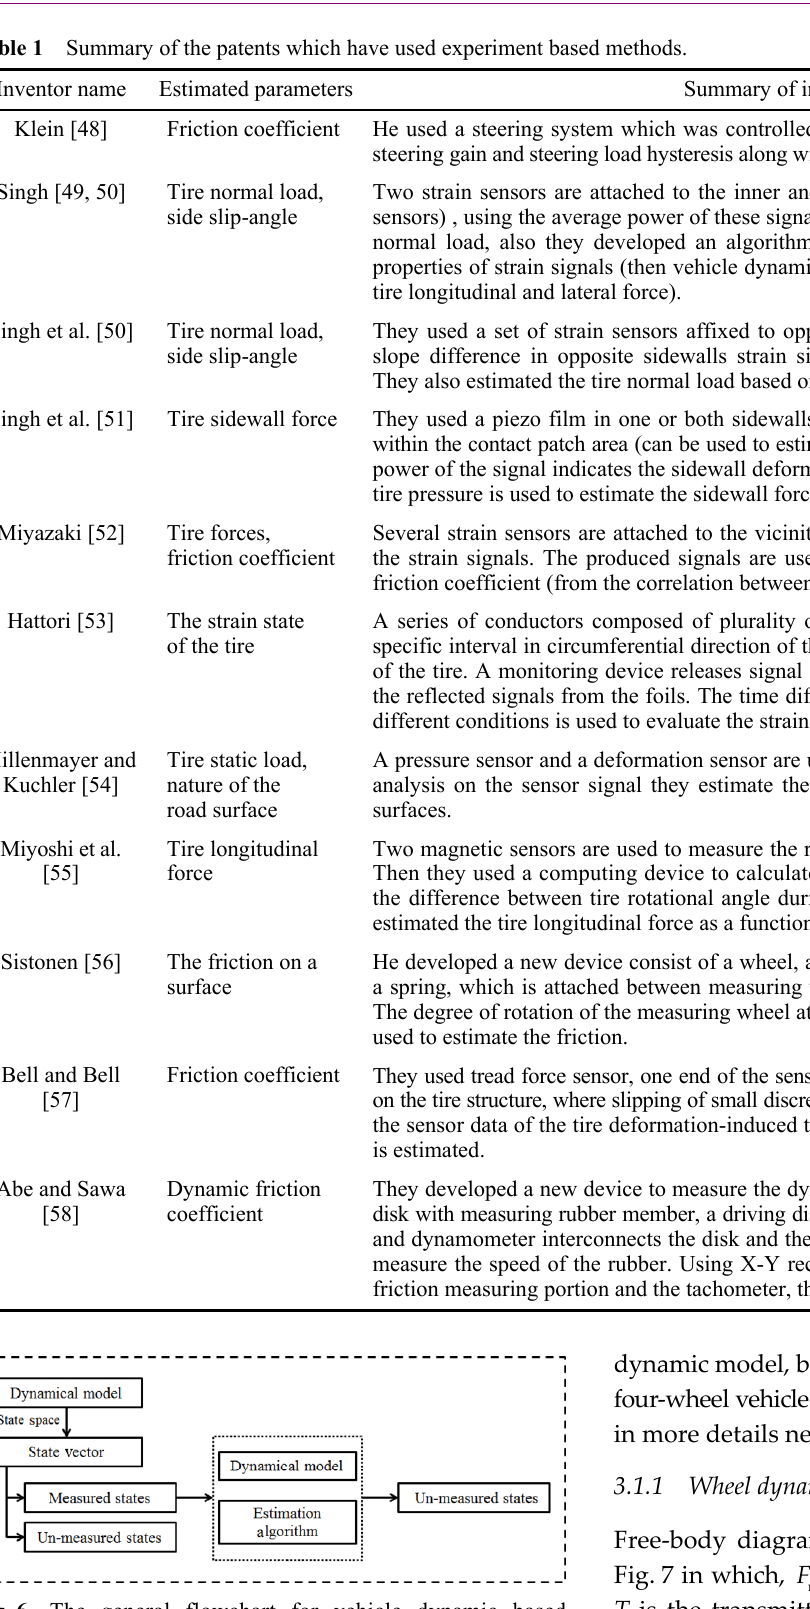
Fig. 6 The general flowchart for vehicle dynamic based approaches.